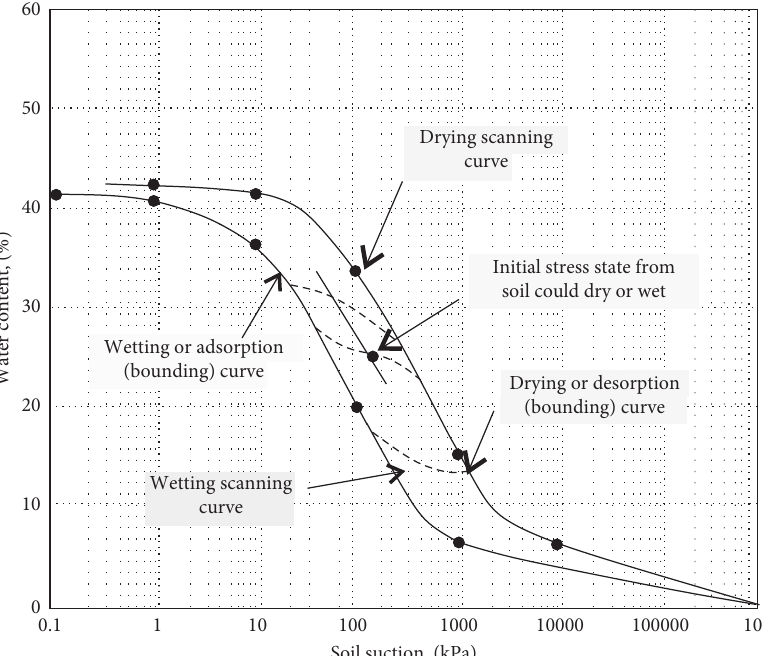
Figure 2: Relationship of initial stress state to hysteresis loops of SWCC (from [49]).